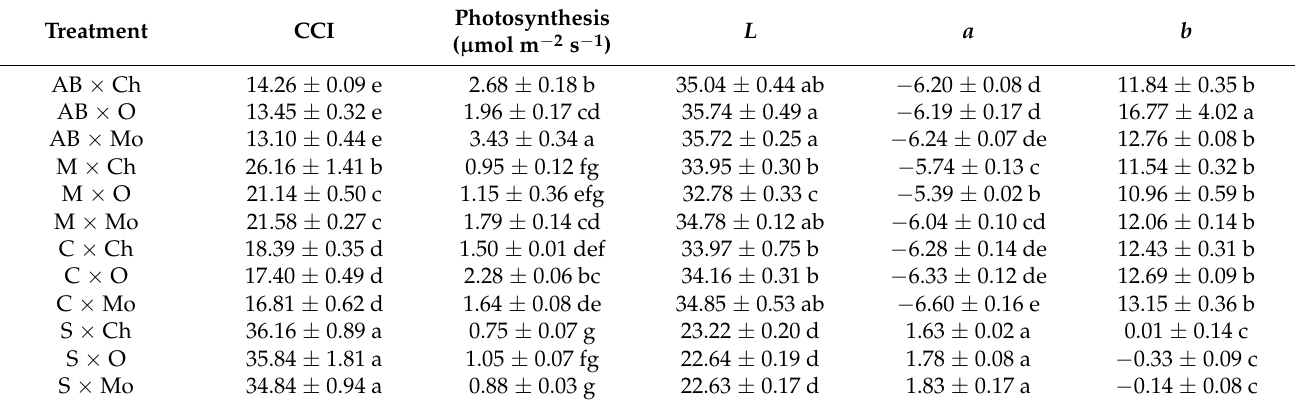
Table 7. Interaction between cultivar and fertilization type on physiological and color parameters.